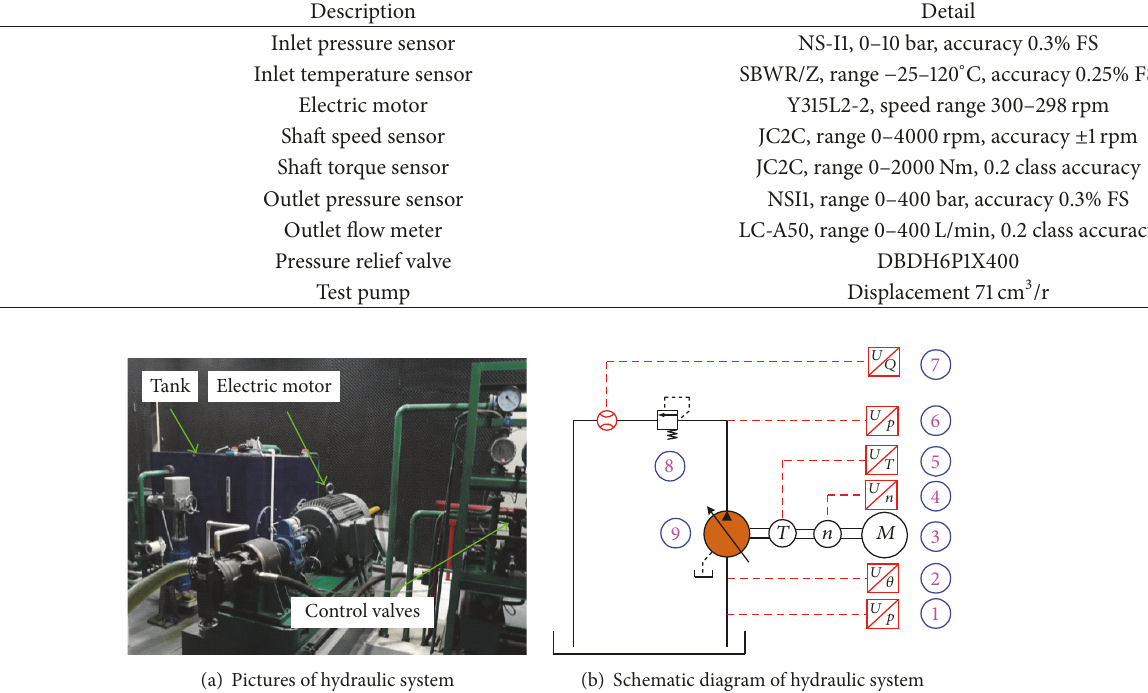
Table 3: Details description of the components in the hydraulics system.